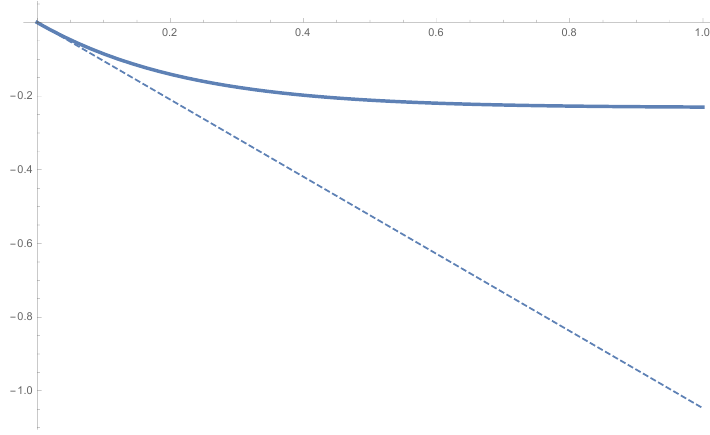
Figure 6 . Comparison of the lower bounds for the expectation value of the energy density weighted by the function f, without the entropy terms. The straight dashed line represents the r.h.s. of equation (3.26) while the solid line is the r.h.s. of equation (3.27). The inequalities are compatible with the previous result by Fewster and Hollands, and the two bounds happen to coincide at the lowest order for small a=(cid:12) . It is important to recall that we are not considering the free entropy terms of the